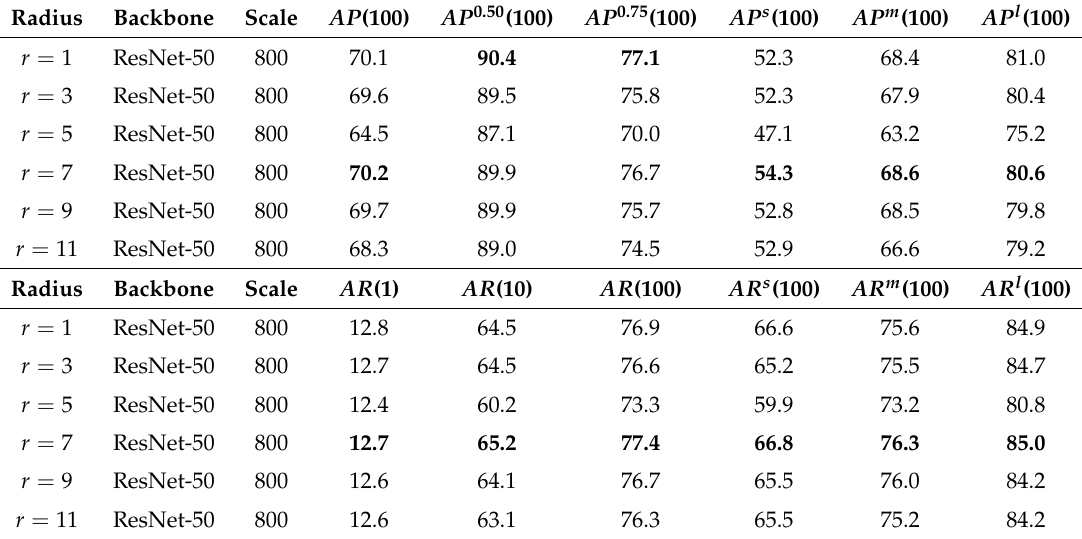
Table 3. Obstacle detection comparisons using radar images with different rendering radiuses on the nuScenes validation dataset [37]. The top sub-table is about average precision metrics. In addition, the bottom sub-table is about average recall